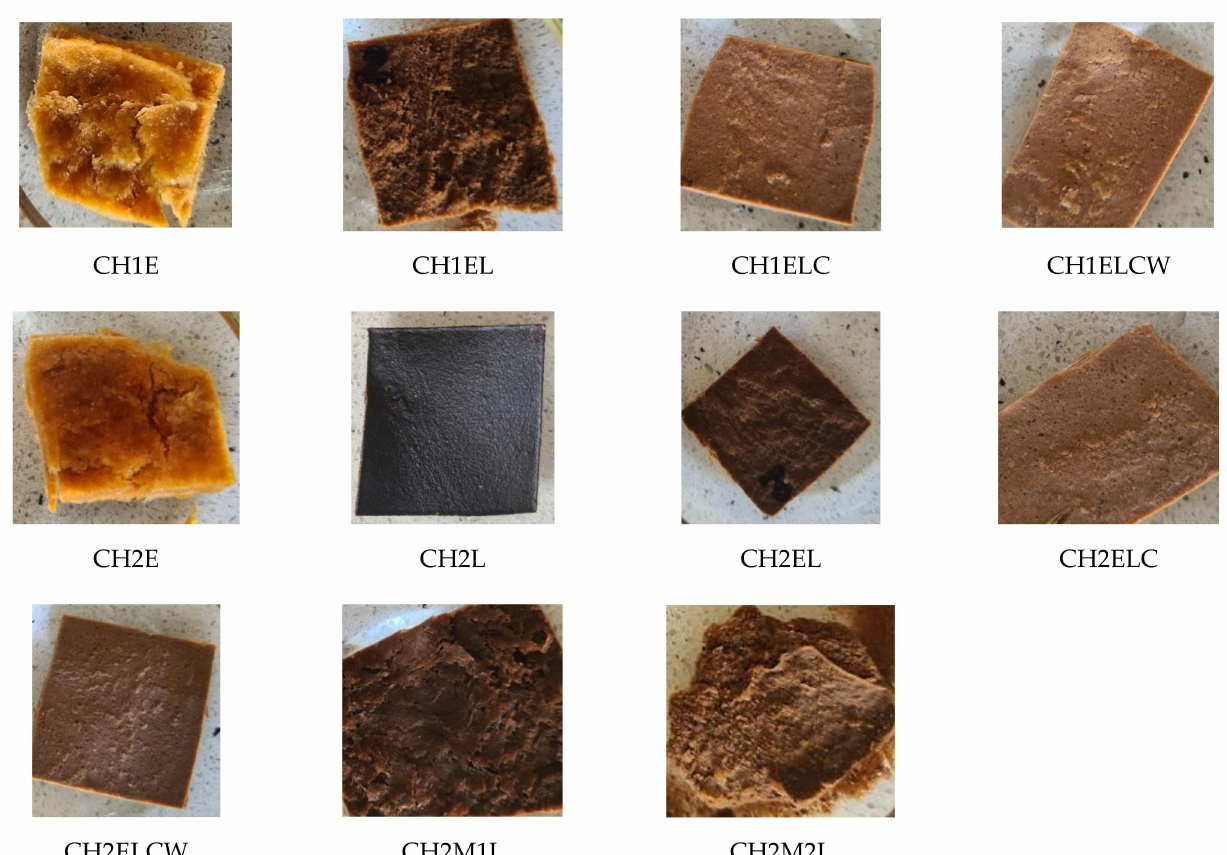
Figure 4. Chitosan/starch-based samples after immersion in water for 24